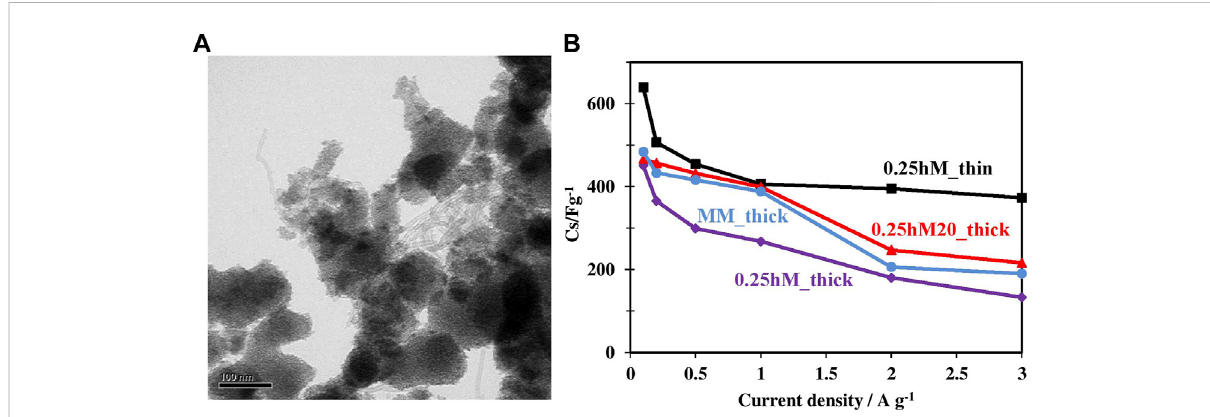
FIGURE 7 (A) TEM image of the 0.25hM10 TiO 2 /CNT composite. (B) Comparison of the rate capabilities of electrodes based on 0.25hM TiO 2 and 20 wt% carbon black (0.2hM), its composites with 10 wt% or 20 wt% CNTs (0.25hM10 and 0.25hM20) and a mechanical mixture of TiO 2 and 20 wt% CNTs (MM).Thelabel “ thin ” afterthesamplenameindicatesanelectrodemassloadingofapproximately1.5 mg cm − 2 since “ thick ” referstoelectrodeswith a mass loading of approximately 9.0 mg cm − 2 .